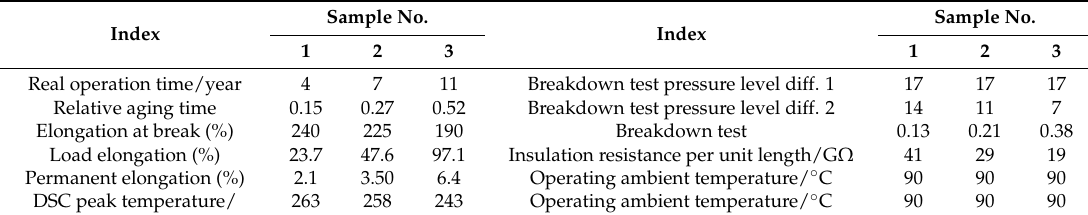
Table 5. Insulating state test indicators of 22 kV XLPE power cable [14].